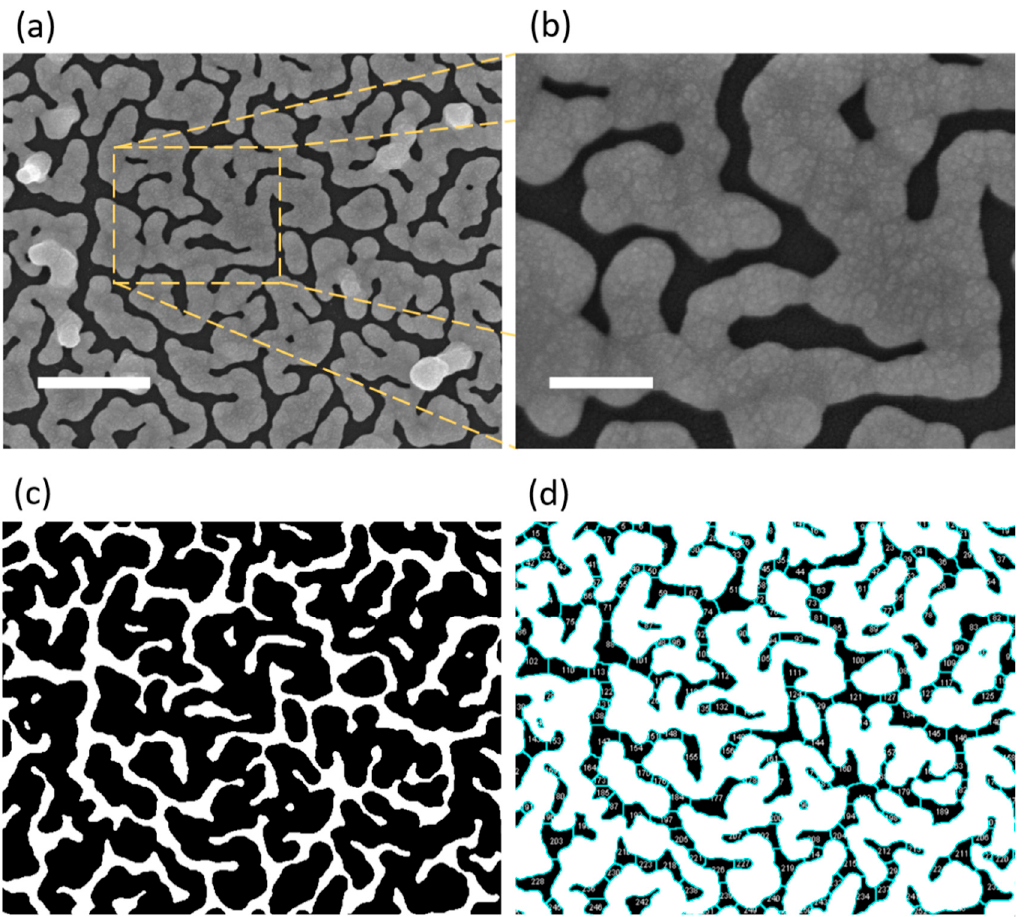
Figure 1. ( a ) SEM image of the gold nanoisland film (Au NIF) (scale bar = 500 nm) and ( b ) the selected magnified area (scale bar = 150 nm). ( c ) The converted binary image of the Au NIF used for the calculation of average nanoisland size from ( a ). ( d ) An inverted image of ( c ) was applied to determine the average inter-island gap distance, where the blue line shows gaps after the watershed segmentation process.